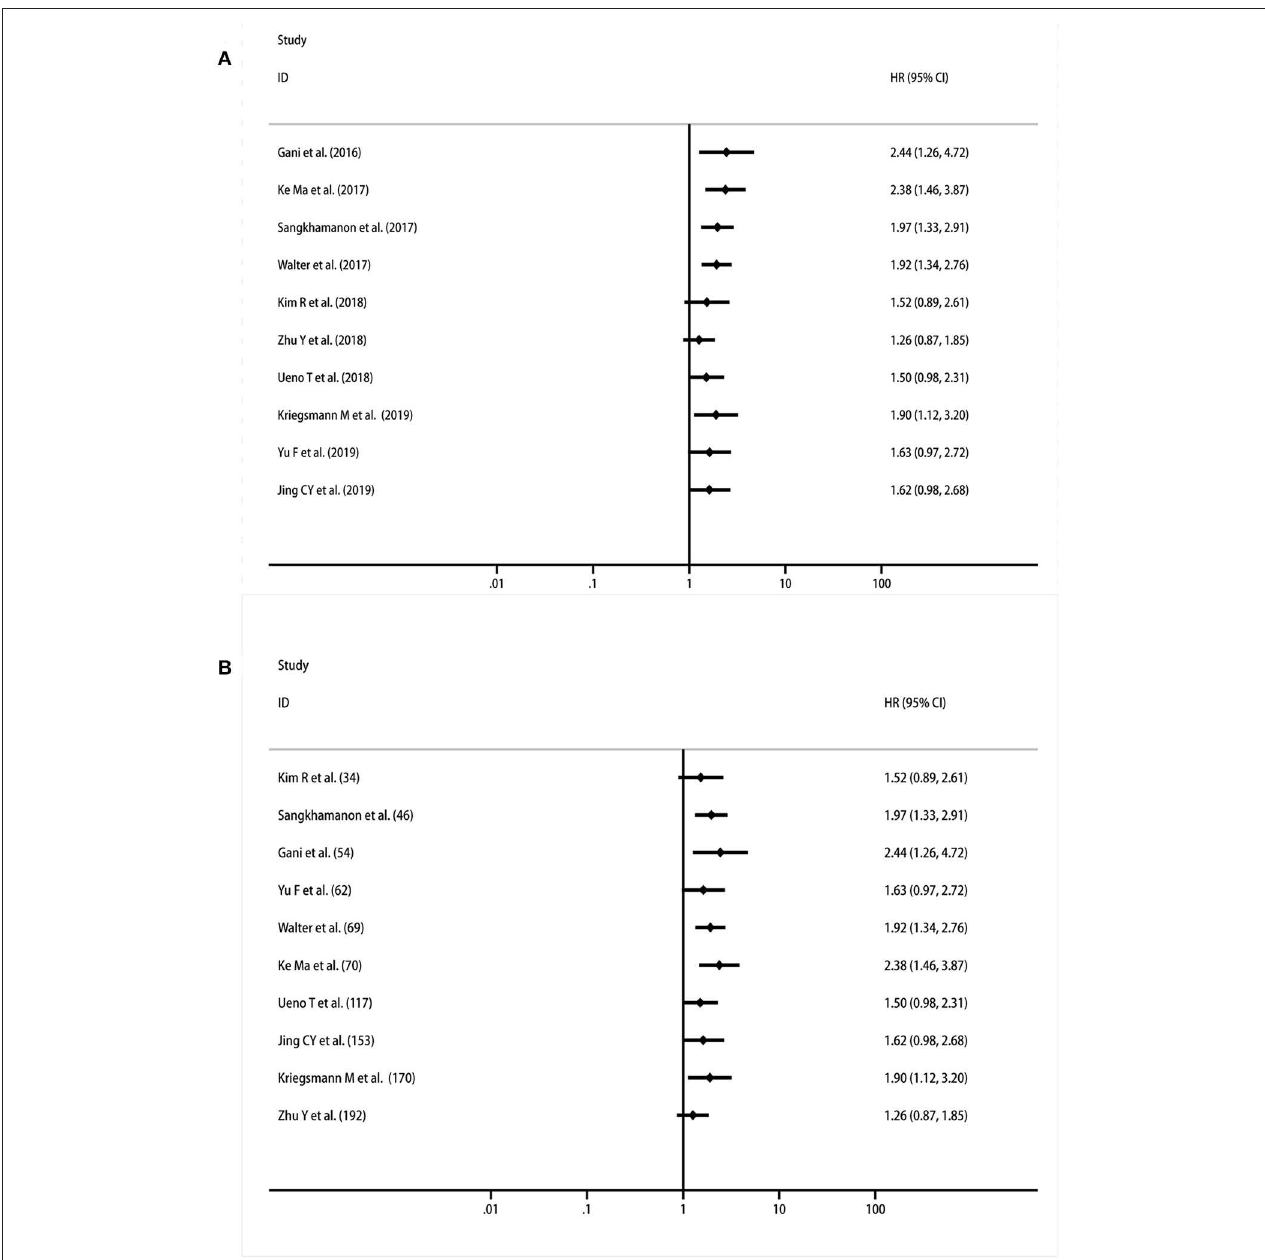
FIGURE 4 | Cumulative meta-analysis of the association between PD-L1 expression in TCs and OS. (A) By years; (B) by sample size. remaining heterogeneity was high ( τ 2 range from 0.792 to